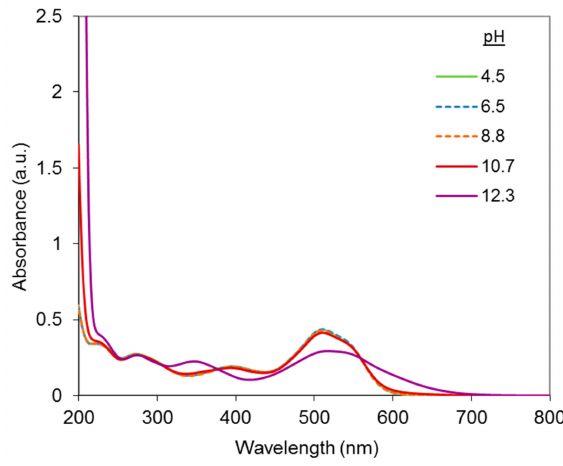
Figure 3. UV-vis spectra of the DR81 dye diluted in water (10 µ M), at different